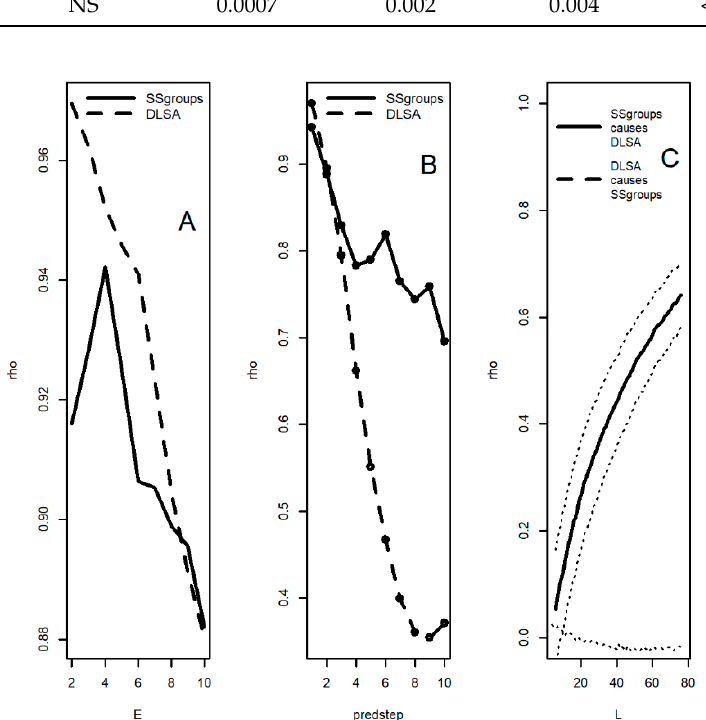
Figure 12. Convergent cross mapping results for sunspot groups and the 1° gridded Desert Locust series 1930–2014. ( A ). Showing use of maximum values of correlation coefficient rho ( ρ ) to estimate the embedding dimension (E) of each series; ( B ) showing decreasing rho with increasing number of prediction steps to confirm non-linearity and ( C ) showing increasing rho with increasing library length (L) for the hypothesis that sunspot groups cause DLSA ( p < 0.0001) and for the converse (DLSA causes sunspot groups, p = 0.69).